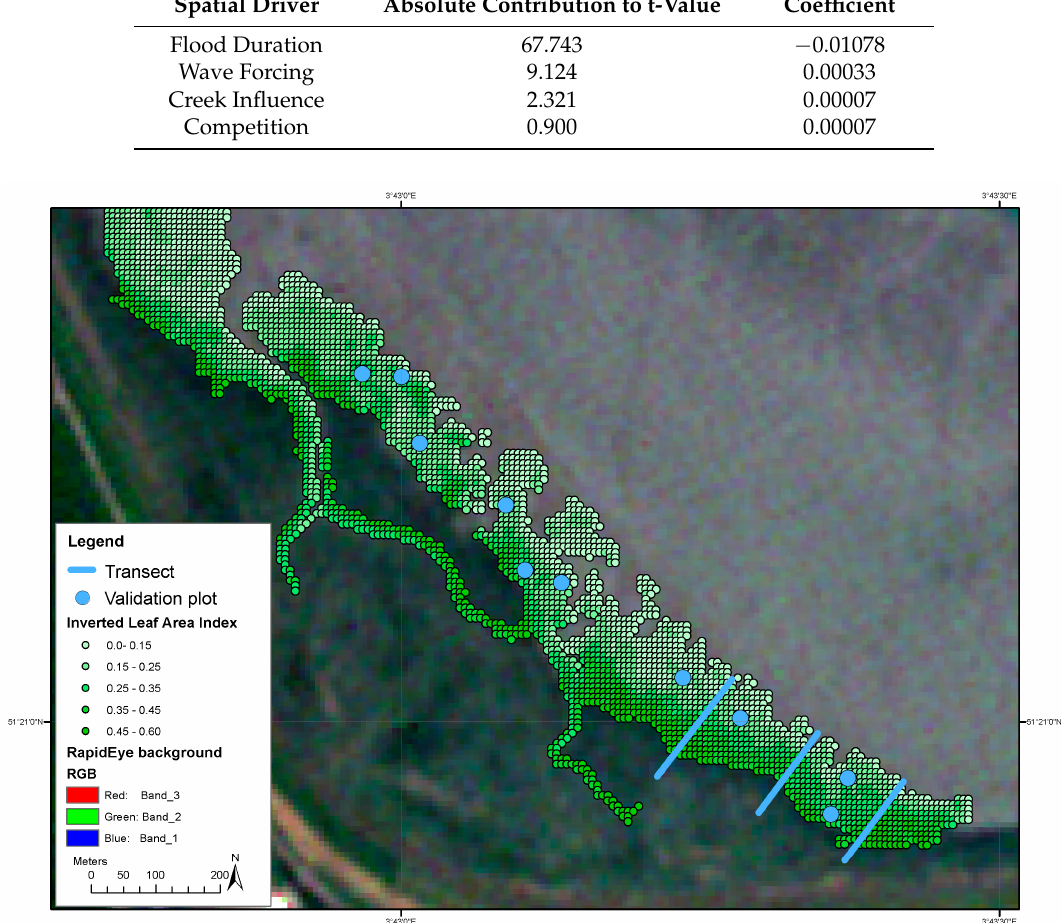
Figure 5. Spatial distribution of Leaf Area Index (LAI) estimated from the inversion of the ProSail model applied to a Rapid Eye image of June 5th 2015. Table 4. the spatial driver correlation coefficients, all spatial drivers were significantly correlated with p values < 0.001.